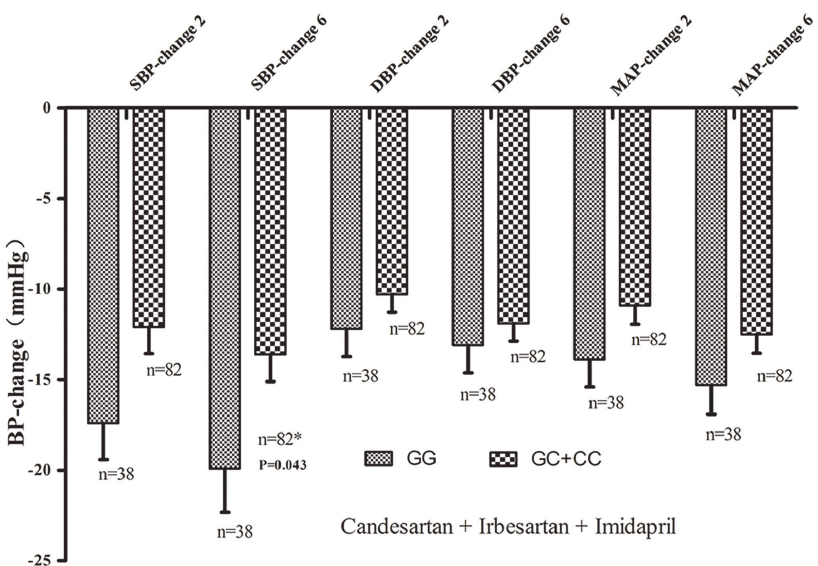
Fig 1. The relationship between the RGS2 (-391, C > G) genetic polymorphism and the hypotensive effects of candesartan, irbesartan or imidapril monotherapy in EH patients. * P- values are shown with age, BMI, and gender adjustments. The error bar indicates 95%